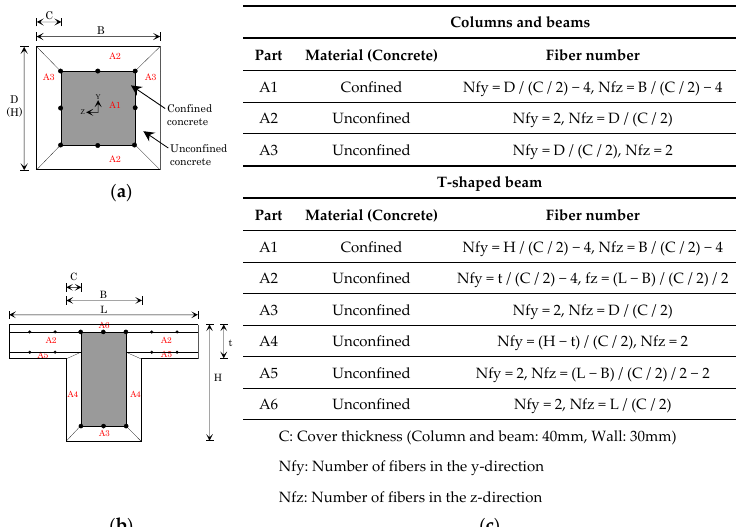
( b ) Figure 5. Constitutive material models in compression and in tension for ( a ) concrete; ( b ) steel. 4.2. Analyzed Parameters To confirm the effect of the effective slab width on the elastic analysis, a parametric analysis was conducted by generating effective slab widths from 0 mm up to 3600 mm at 25 mm intervals. Based on these results, a T-shaped beam cross-section was generated to